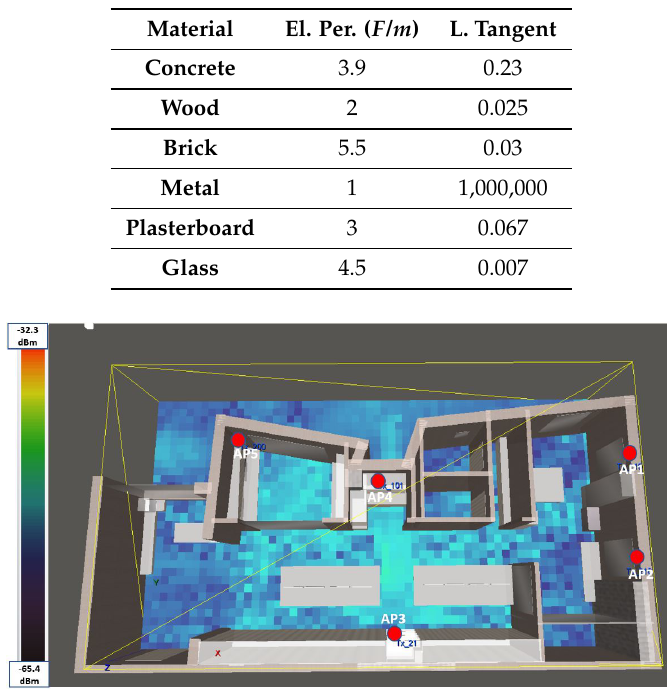
Figure 4. TruNET Wireless Simulator Radiomap for Access Point